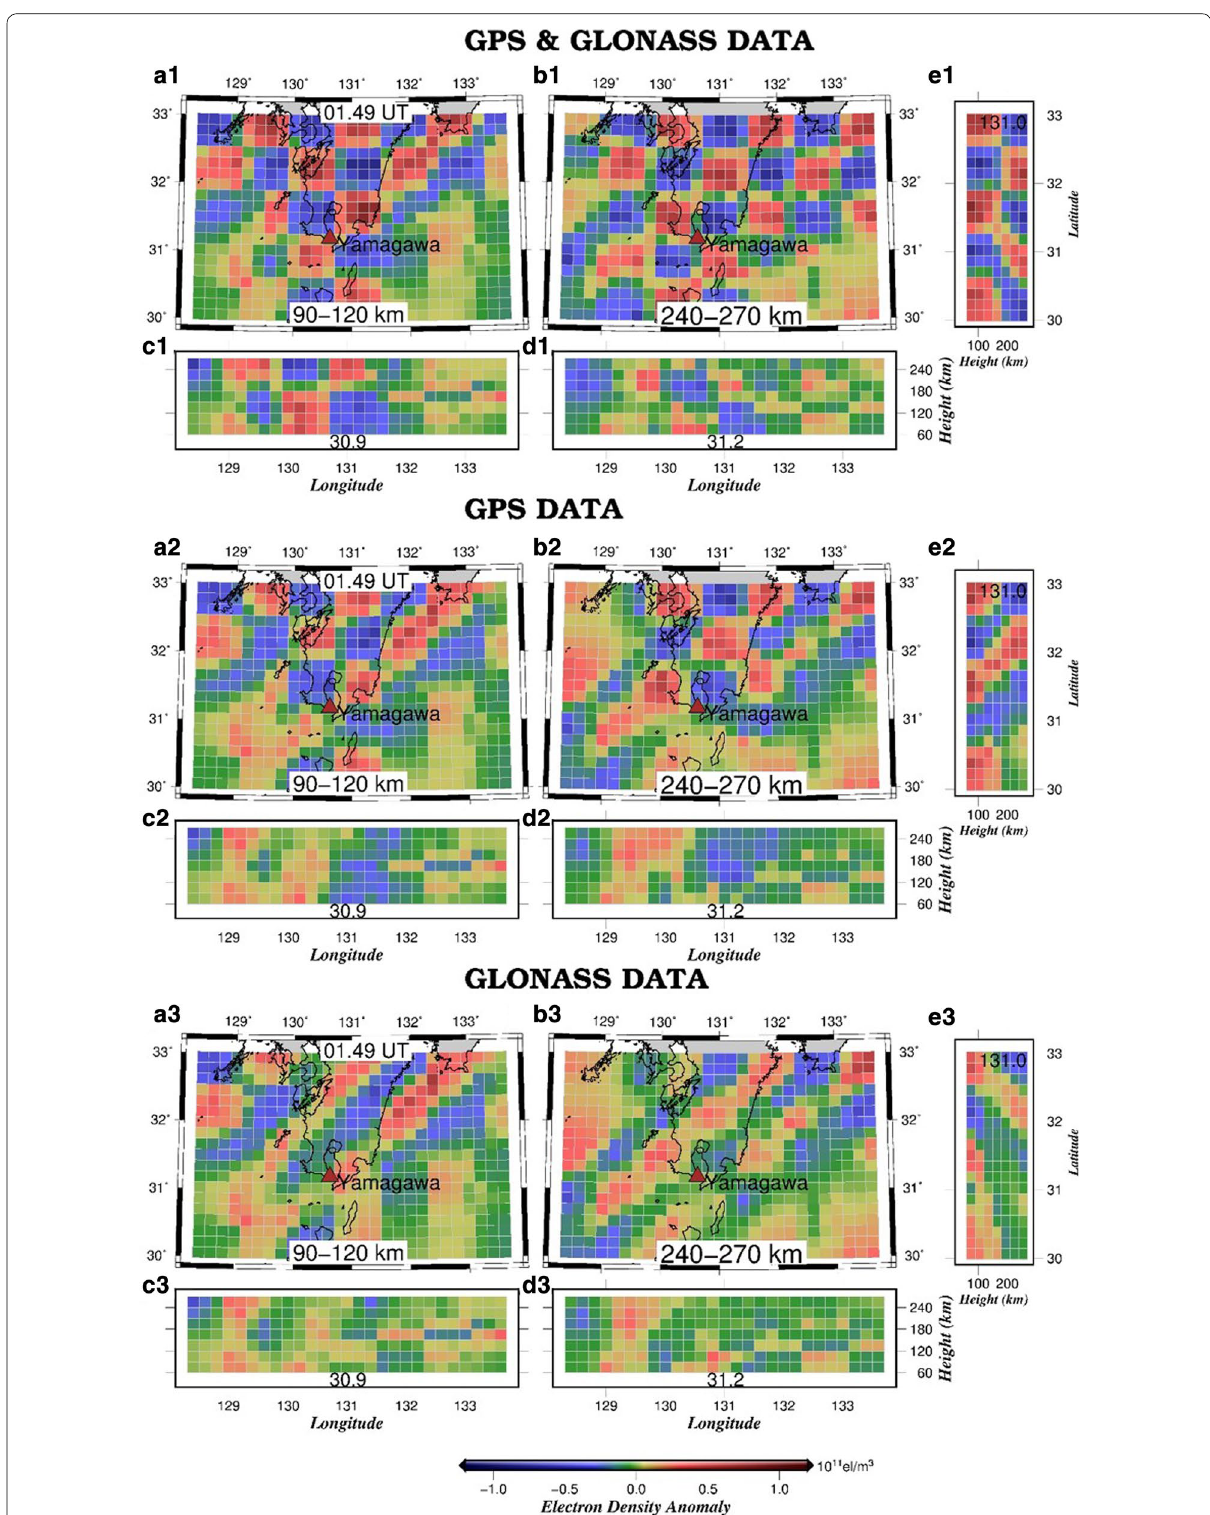
Fig. 10 Results of the checkerboard test for Case 5 using both GPS and GLONASS data (top), GPS data only (middle), and GLONASS data only (bot- tom). In each case, we give map views at two different altitudes, namely 90–120 km ( a1–a3 ) and 240–270 km ( b1–b3 ), and latitude–height profile in ( e1–e3 ), and two longitude-height profiles in ( c1–c3, d1–d3